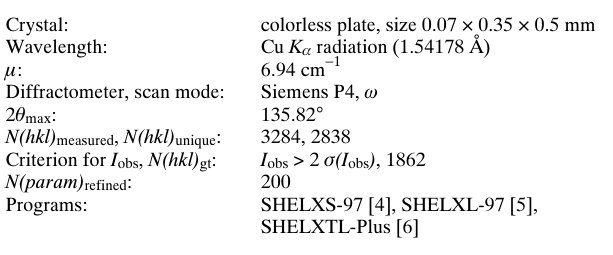
Table 1. Datacollection and handling.